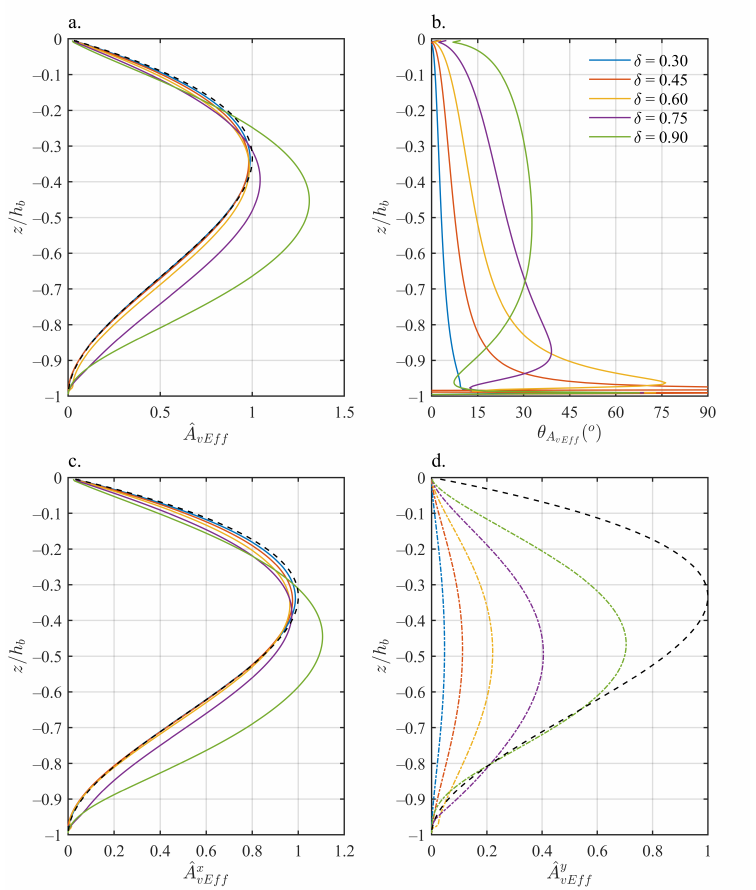
Figure 12. Effective eddy viscosity inferred from the diurnal averaged velocity under various δ at latitude 60° N. ( a ) ˆ A vEf f , the magnitude of A vEf f normalized by A 0 ; ( b ) θ A , the angle of A vEf f , vEff which is relative to the local mean shear direction; ( c ) ˆ A x , the real (zonal) component of ˆ A vEf f , vEf f and ( d ) ˆ A y , the imaginary (meridional) component of ˆ A vEf f . The black dashed line in ( a , c , d ) vEf f stands for the normalized vertical eddy viscosity from KPP ( ˆ A = A / A 0